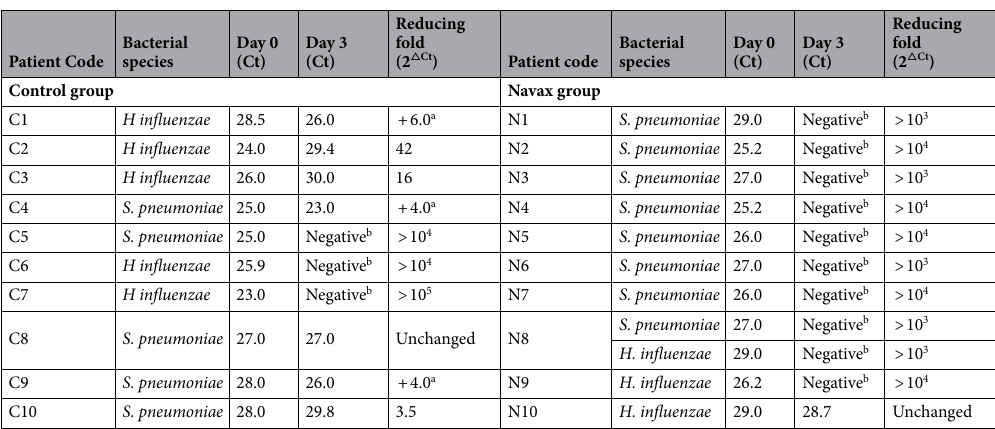
Table 3. Fold-changes in co-infection bacteria’s concentrations in nasal tract of Navax and Control group after 3 days of treatment. + a : Increasing fold but not reducing fold. Negative b : SYBR Green fluorescent signal is not detectable or equivalent to C t >